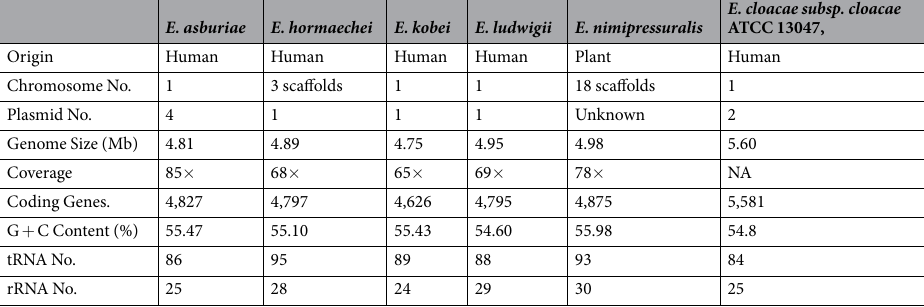
Table 1. Genomic features of Enterobacter strains analysed in this